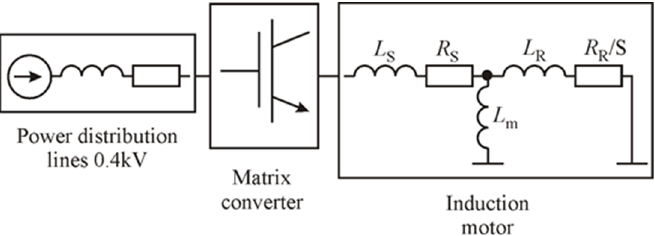
Figure 11. A per-phase simplified representation of the induction motor and the matrix-converter- based reactive power compensation device